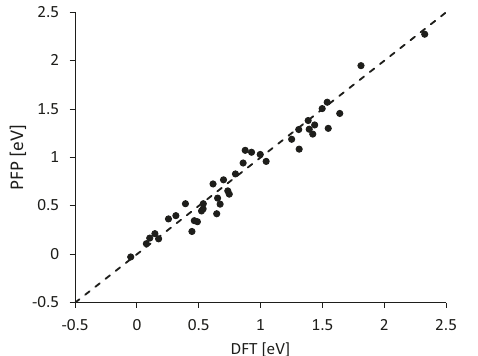
Fig. 4 Comparison of the activation energies of methanation reactions of synthesis gas on Co(0001). The ordinate and abscissa represent the PFP prediction and reference DFT values, respectively. The zero-point energy corrections of the transition states are also included in the data.